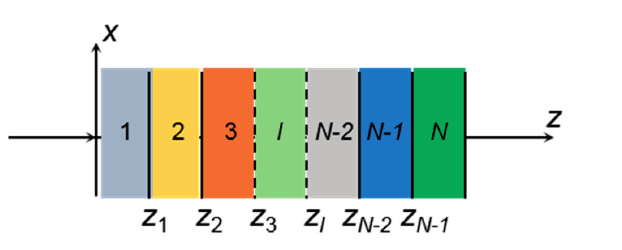
Figure 1. 1D multilayer planar